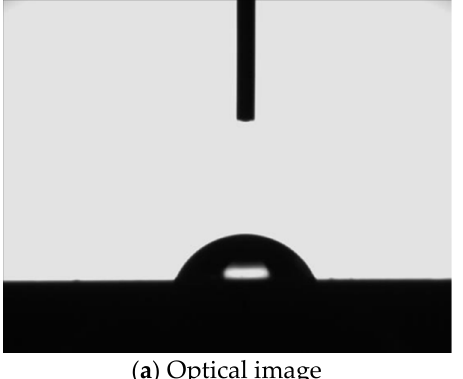
Figure 10. Tangent line method.